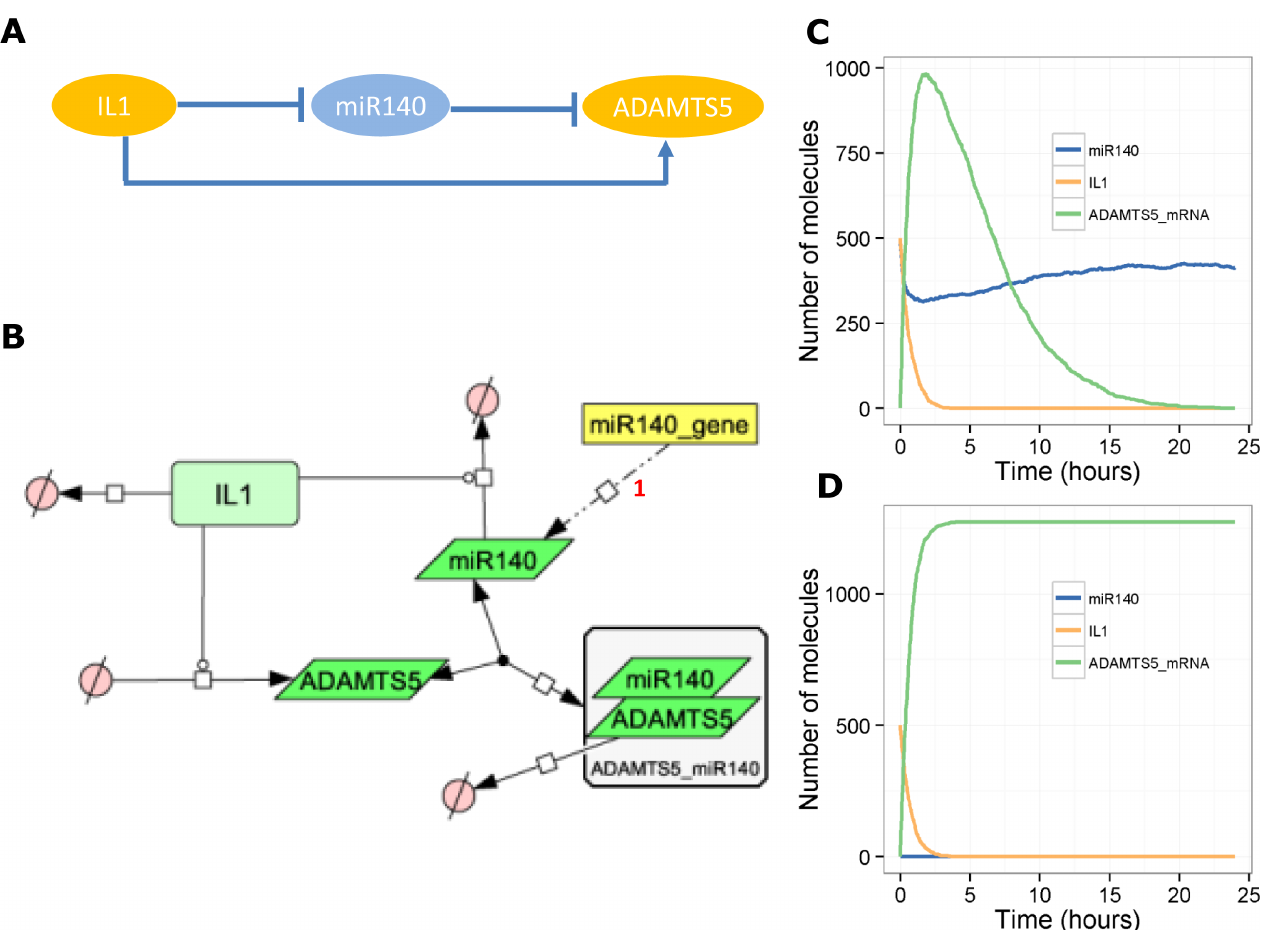
Fig 4. Model of the interaction between miR-140, IL-1 and ADAMTS5 . A , Network motif showingcoherentfeedforwardloop. B , Diagramof full model. C - D , Output from one stochastic simulation, C, with miR-140(miR140= 500 initially, k synmiR140 = 0.0018 s -1 ) or D, without miR-140 (miR140= 0 initially, k synmiR140 = 0.0 s -1